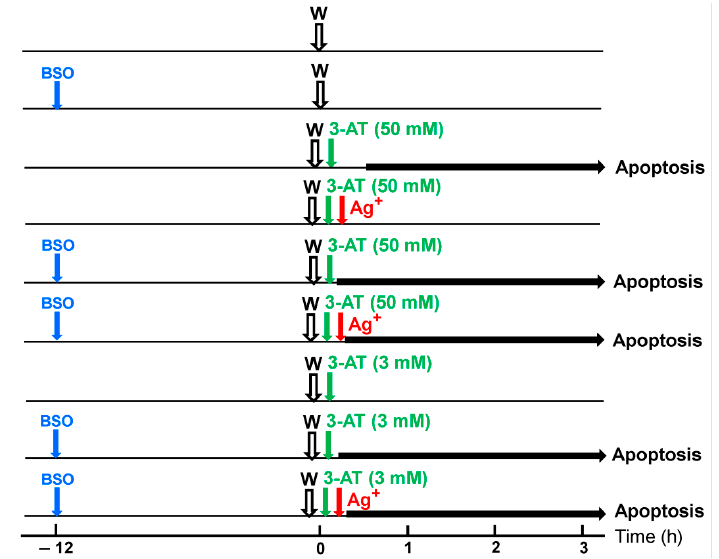
Figure 6. Pretreatment with the glutathione synthase inhibitor BSO substitutes for the effect of aquaporins. MKN-45 cells (125,000 cells/mL) were pretreated without BSO (control) or in the presence of 10 µM or 50 µM BSO for 12 h at 37 °C. The cells were washed and seeded in 96 well plates (12,500 cells per assay). Where indicated, 5 µM Ag + was added after seeding in the 96 well plates. The percentages of apoptotic cells were determined after 3 h in BSO pretreated cultures and 4.5 h in controls. ( A ): The data show that BSO-pretreatment is not sufficient for apoptosis induction alone but increases the efficiency of low concentrations of 3-AT, but not of high concentrations. ( B ): Apoptosis induction in control cells is dependent on inhibition of catalase and on the action of aquaporins, as it requires inhibition of catalase and is completely blocked by Ag + . ( C , D ): BSO-pretreated cells require catalase inhibition for apoptosis induction in a process that is independent of the action of aquaporins, as seen by the lack of inhibition by Ag + . These data show that the effects of aquaporin action can be explained by glutathione depletion. Statistical analysis. ( A ): The enhancing effect of BSO pretreatment at low concentrations of 3-AT were highly significant ( p < 0.001). ( B ): Inhibition by Ag + was highly significant ( p < 0.001). ( C , D ): The lack of inhibition by Ag + after BSO pretreatment was highly significant ( p < 0.001). The scheme to Figure 6 illustrates that the tumor cells do not show apoptosis in the absence of catalase inhibitor, even if they have their intracellular glutathione level has been lowered by BSO treatment. Addition of 50 mM 3-AT leads to apoptosis induction characterized by a lag phase and dependence on aquaporin action, as it is inhibited by Ag + . Pretreatment with BSO, followed by the addition of 50 mM 3-AT leads to apoptosis induction without a lag phase and independent of aquaporin function. This finding shows that glutathione depletion substitutes for the aquaporin effect. 3 mM 3-AT was not sufficient for apoptosis induction in control cells but allowed apoptosis induction in BSO-pretreated cells without a lag phase and independent of aquaporin function, indicating that BSO treatment sensitized the cells for apoptosis induction and substituted for the aquaporin